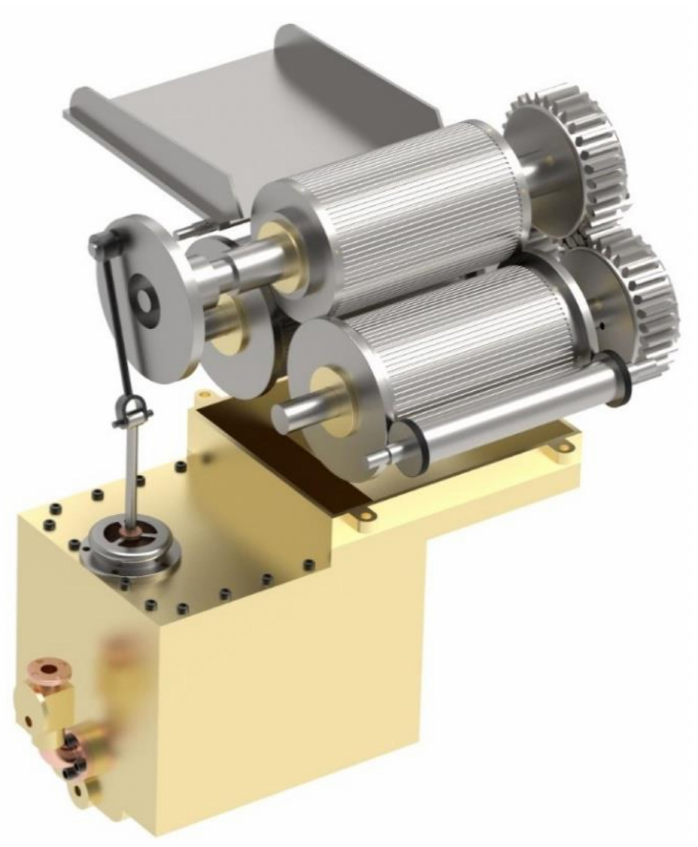
Figure 23. Assembly of the milling